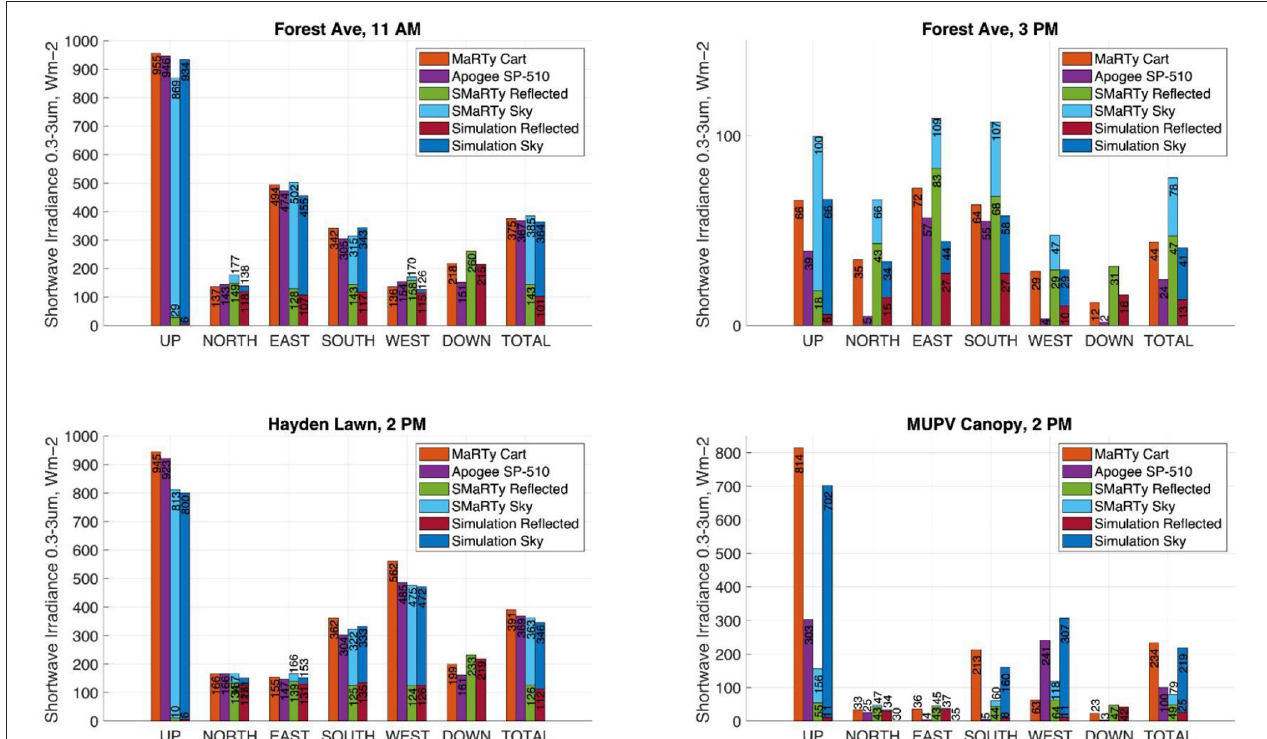
FIGURE 10 | Shortwave radiation,W · m − 2 , measured at 11 am and 3 pm at Forest Ave by the COOR, and at 2 pm at the Hayden Lawn and at the MUPV Canopy. Planar irradiance values are from each direction and the overall average, from the MaRTy cart (left bar), the Apogee Pyranometer (middle-left bar), SMaRT array (middle-right bar), and the simulation data (right bar). The SMaRT-SL and simulation data are broken into direct sky and reflected ground components by utilizing their greater degree of resolution.